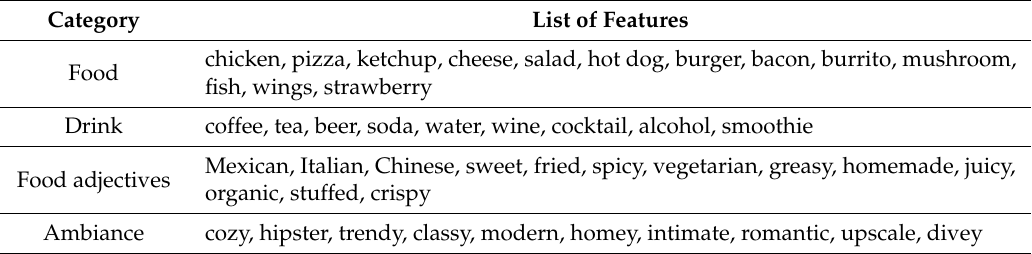
Table A1. List of 45 Features Used as Seed to Word2Vec Model.